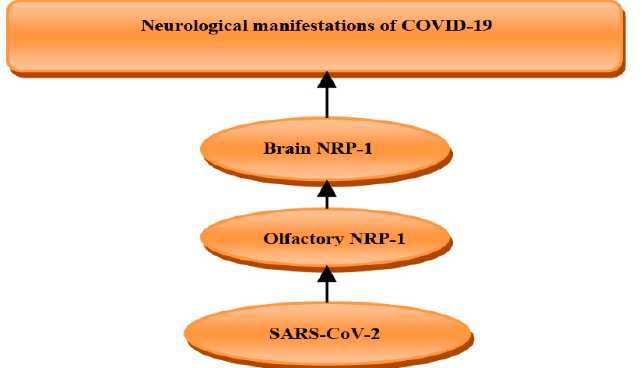
Figure 6. The role of neuropilin-1 (NRP-1) in SARS-CoV-2 infection: SARS-CoV-2 binds olfactory NRP-1 and is transmitted to the brain leading to induction of neurological manifestations of COVID- 19.